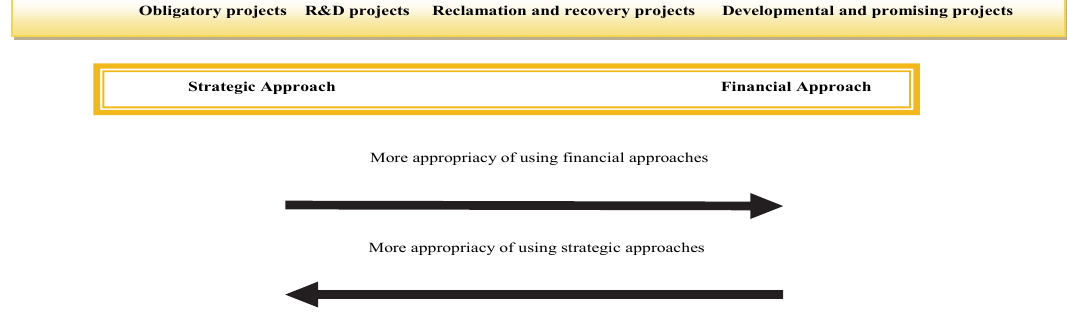
Fig. 3. The importance of financial and strategic approaches in evaluation of different investment